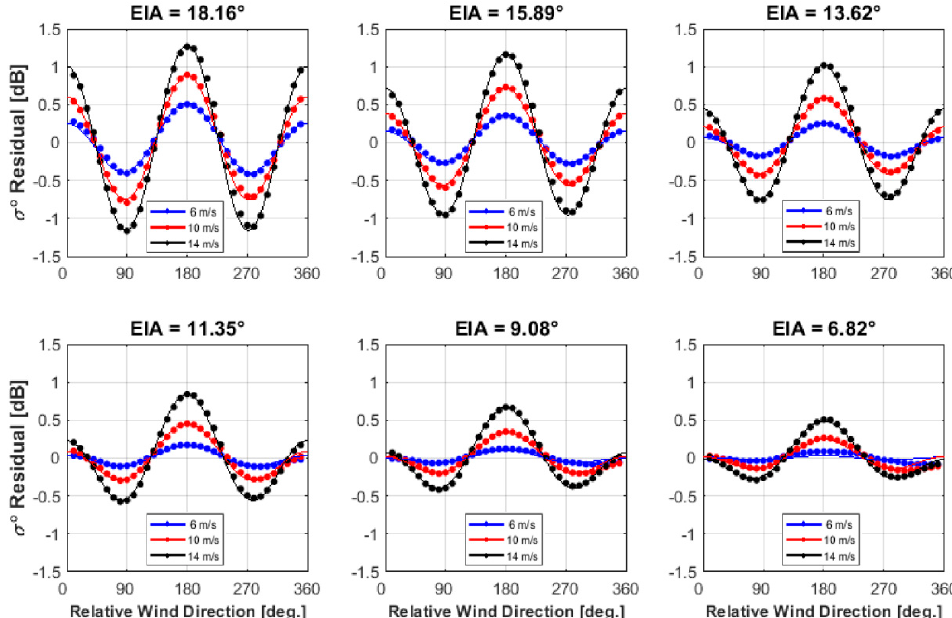
Figure 13. KuPR σ 0 directional anisotropy (in dB) as a function of relative wind direction ( χ ), for three different WS values: 6 m/s (blue), 10 m/s (red), and 14 m/s (black) at different earth incidence angles. The symbols are bin average while the solid lines represent their second-order Fourier fits.